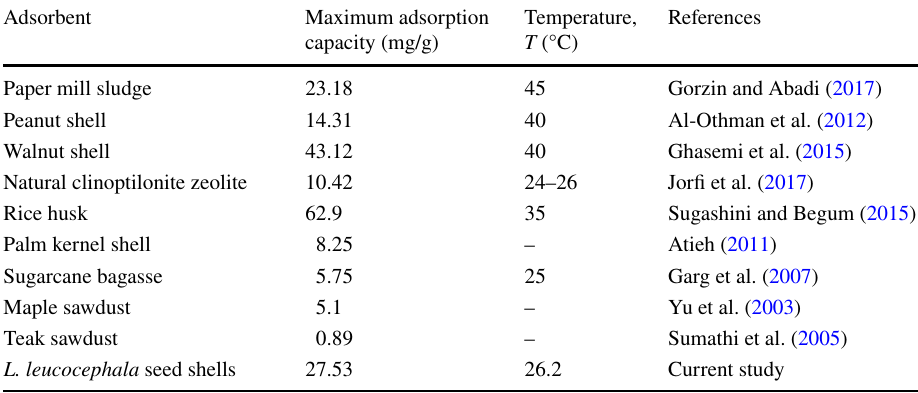
maximum adsorption capacities of different adsorbents for Cr(VI) removal from aqueous